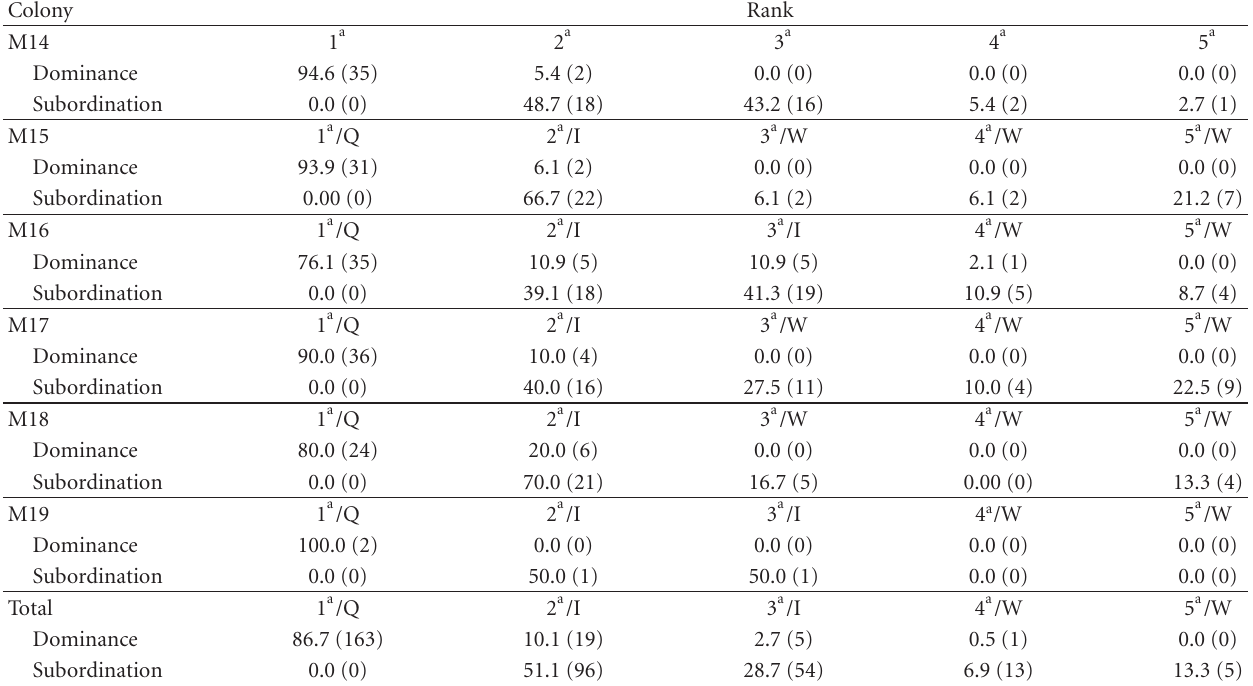
Table 2: Dominance and subordination behaviors (% absolute number) of each individual by colony during the determination of domi- nance